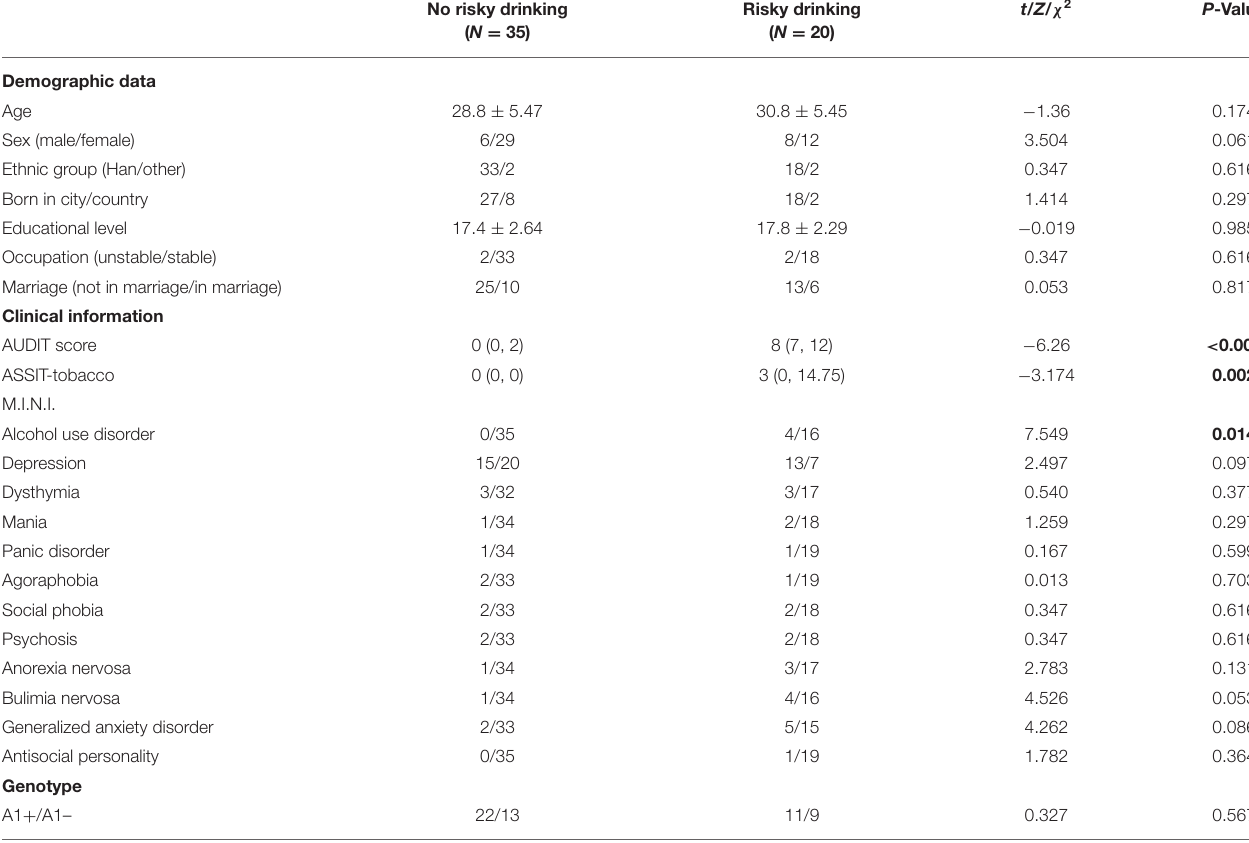
TABLE 1 | Demographic status, clinical features and genotypes among offspring of parents with alcohol dependence based on current risky drinking.